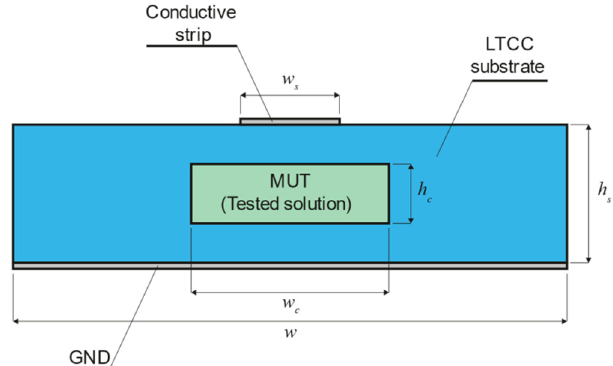
Figure 5. The cross-section of the sensing structure with the microfluidic channel embedded inside the substrate of the microstrip line.